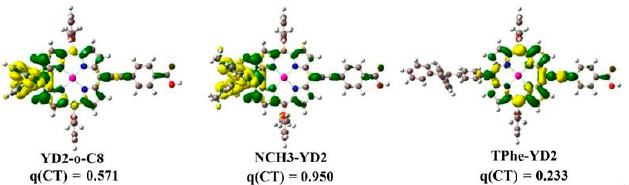
Figure 2. The electron density variation ( Δρ ) between the excited state and ground state. The green color indicates increased electron density, while yellow color indicates decreased electron density. q(CT) is the amount of charge transfer (e-).